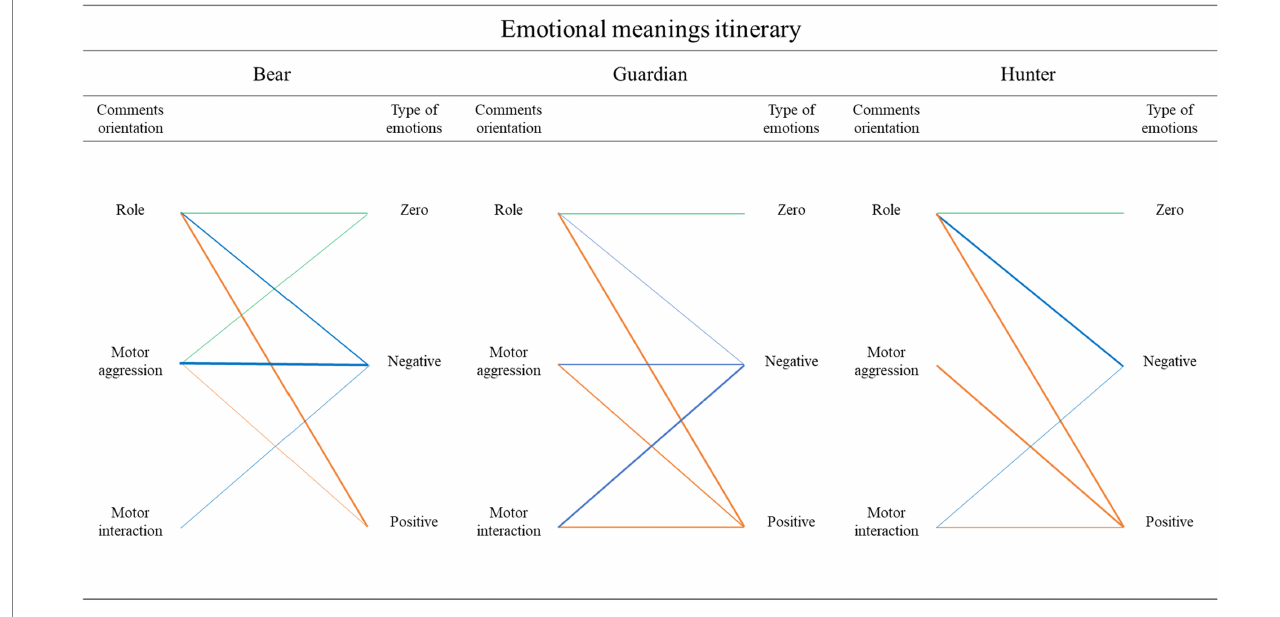
FIGURE 6 Emotional itinerary in the chained roles. The thickness of the lines corresponds to the frequency of comments. The thicker the lines, the more comments there are.